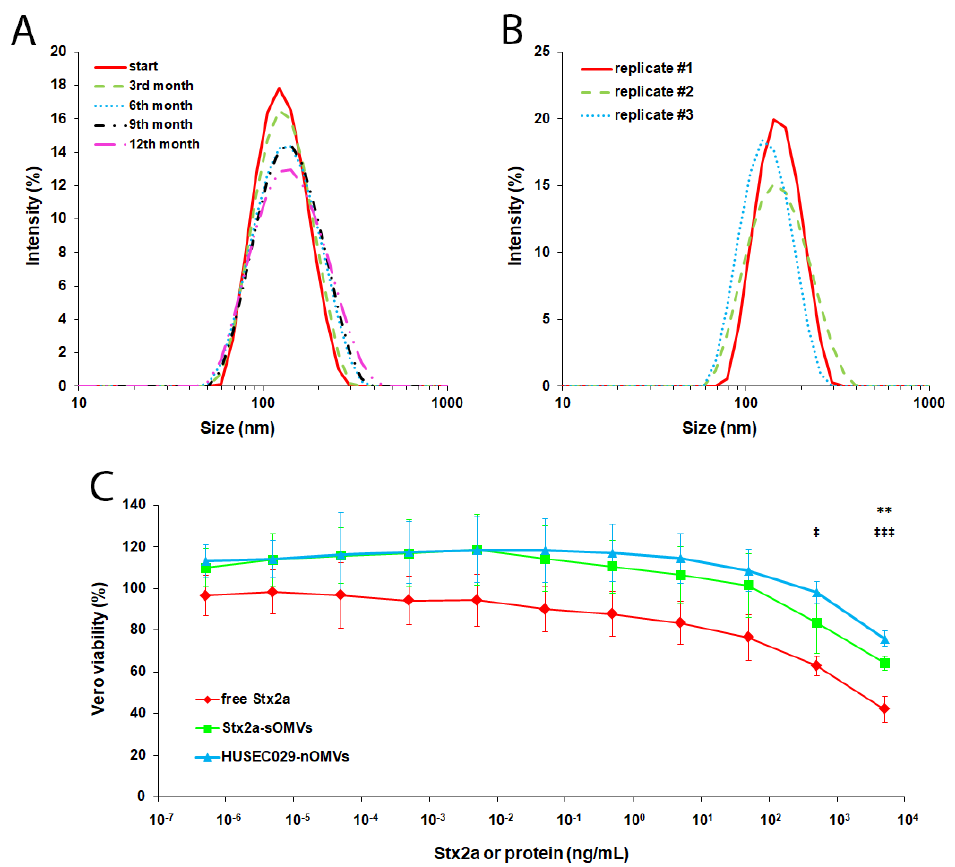
Figure 2. Long-term storage of sOMVs and properties of Stx2a-loaded sOMVs. Depicted in ( A , B ) is the size distribution as measured by dynamic light scattering (DLS). ( A ) Bovine serum albumin (BSA)-loaded sOMVs were stored at 4 ◦ C and analyzed at the indicated time-points for structural integrity. A sample representative of three biological replicates is shown over time. ( B ) Size distribution of three biological replicates of Stx2a-loaded sOMVs (also stored at 4 ◦ C) indicated by differently colored lines. ( C ) Cytotoxicity of free Stx2a, Stx2a-loaded sOMVs, and Stx2a-containing HUSEC029 native outer membrane vesicles (nOMVs) toward Vero cells, as determined by the crystal violet assay. The indicated concentrations refer to Stx2a for measurements with free Stx2a and Stx2a-loaded sOMVs or total protein for nOMVs of HUSEC029, respectively. Depicted is the mean ± standard deviation in relation to an untreated control of three biological replicates ( n = 3) each performed in triplicates. Statistical analyses were performed by ANOVA with Bonferroni correction comparing free Stx2a with Stx2a-sOMVs (*) or with HUSEC029-nOMVs ( ‡ ), respectively, and significances are indicated as follows: * / ‡ , p < 0.05; ** / ‡‡ , p < 0.01; *** / ‡‡‡ , p < 0.001 (comparing Stx2a-sOMVs with HUSEC029-nOMVs yielded no significant differences).